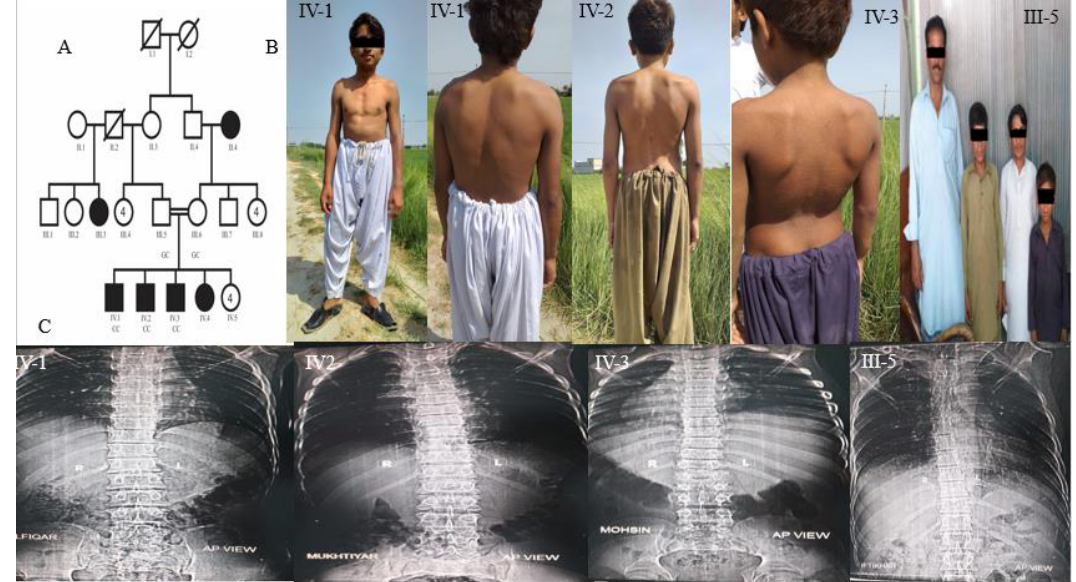
Figure 1. Pedigree and clinical manifestations. ( A ) Pedigrees of a consanguineous Pakistani fam- ily segregating autosomal recessive form of brachyolmia. Double lines are indicative of consan- guineous union. Clear symbols represent unaffected individuals, while filled symbols represent affected individuals. The diagonal line through a symbol is indicative of a deceased family member. ( B ) Affected individual IV.1 showing disproportionate short trunk and relatively long upper ex- tremities. Individual IV.2 and IV.3 showing mild scoliosis. Individuals IV-1, IV-2 and IV-3 with their unaffected father III-5. ( C ) Radiographic features of brachyolmia. in three patients and one control. Radiograph of spines of affected members IV.1, IV.2 and IV.3 showing mild scoliosis and platyspondyly and irregular end plates. Radiograph of III-5 showing normal